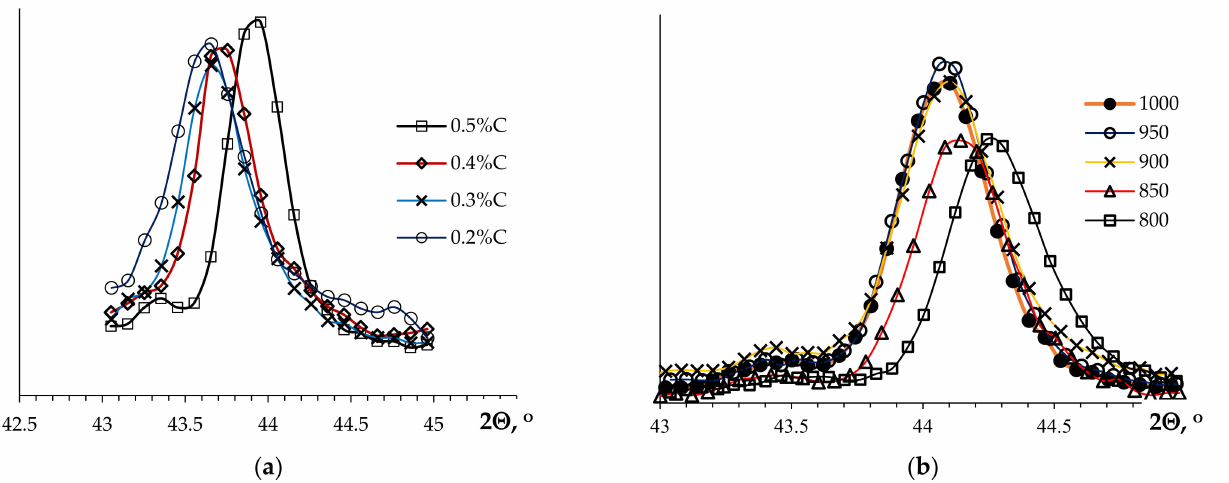
Figure 14. Position measurements of XRD peak (111) β -100 in an WC-10Co hard alloy obtained by the SPS of submicron powders: ( a ) impact of graphite concentration at the sintering temperature of 1400 ◦ C; ( b ) impact of SPS temperature for a 0.5% graphite